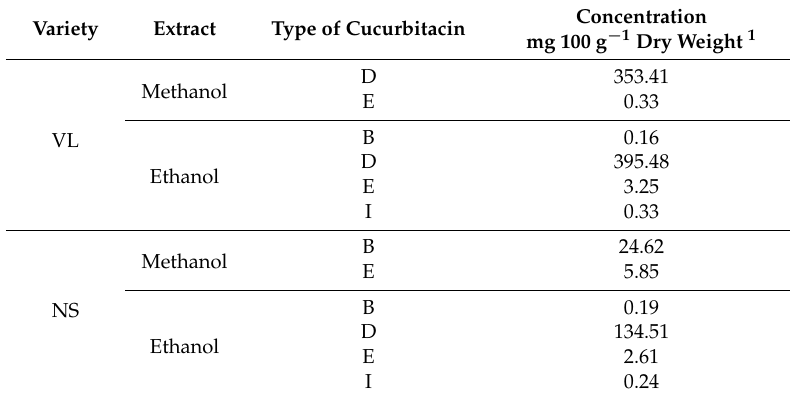
Table 3. Concentration of cucurbitacins in extracts of fruit from Sechium edule var . virens levis (VL) and S. edule var . nigrum spinosum